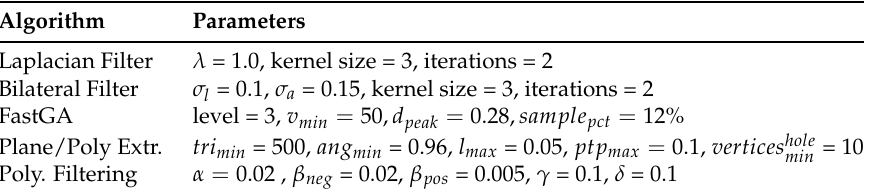
Table 7. Polylidar3D Parameters for RealSense RGBD.